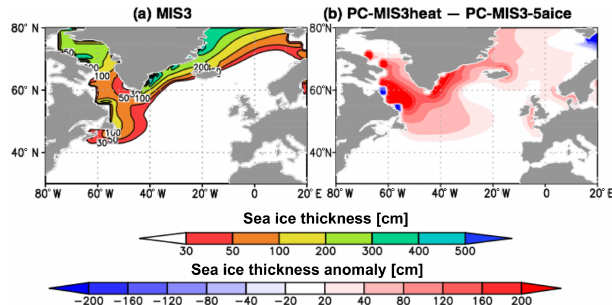
Figure 11. Annual mean sea ice thickness (cm, color) over the North Atlantic simulated from the AOGCM and partially coupled experiments. Panel (a) shows MIS3, and panel (b) shows the effect of surface cooling by the mid-glacial ice sheet (PC-MIS3heat minus PC-MIS3-5aice). The results of the last 100 years are used.